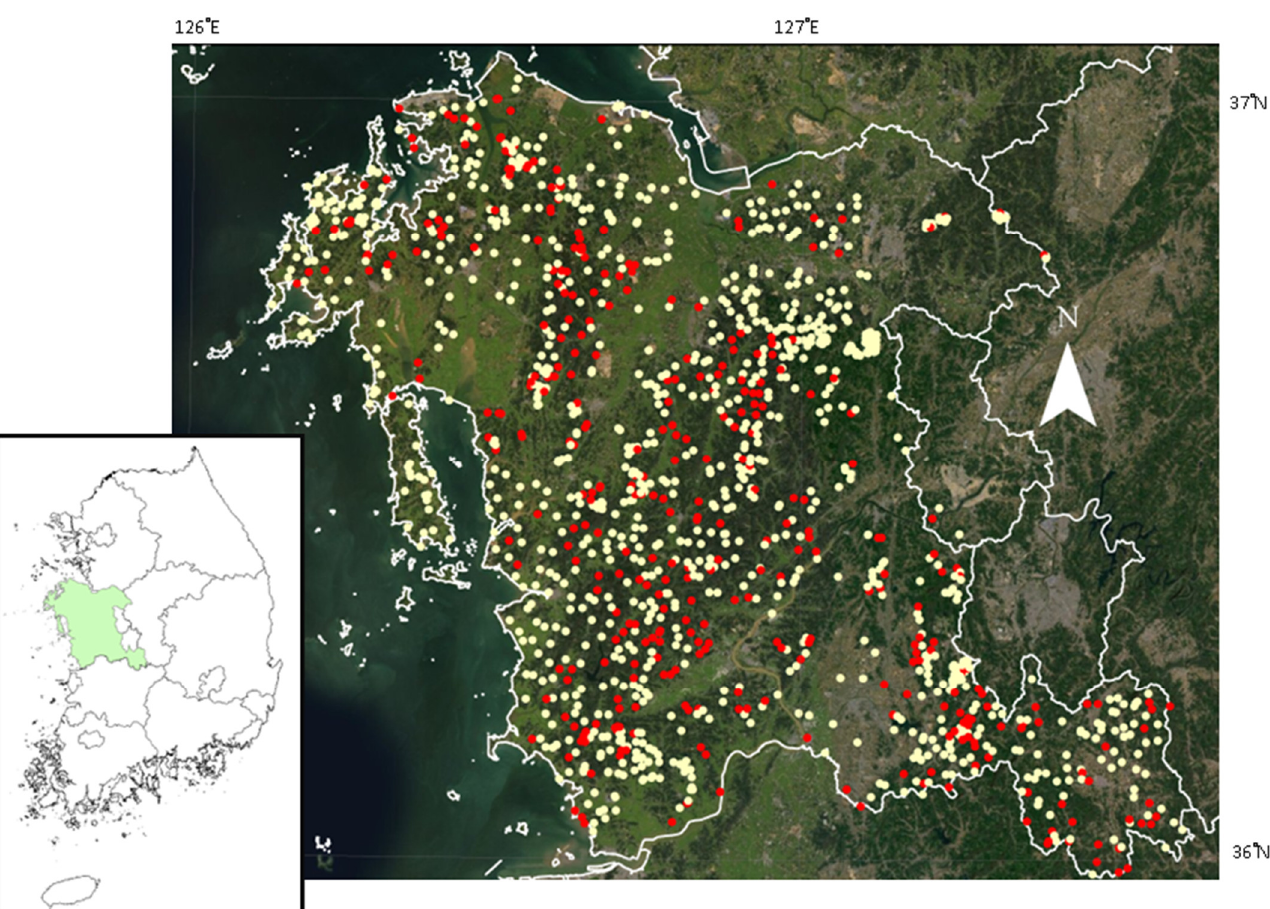
Figure 1. Locations of sampling points for leopard cats in the Chungnam Province, South Korea. Sampling points with and without the traces of leopard cats were marked with red and yellow, respectively.